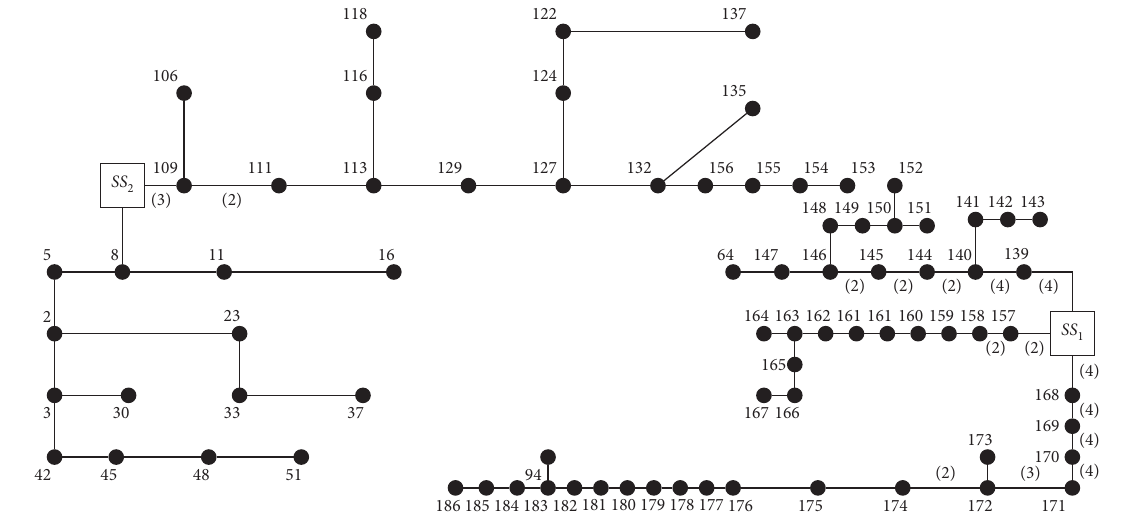
Figure 11: Case D: primary network.